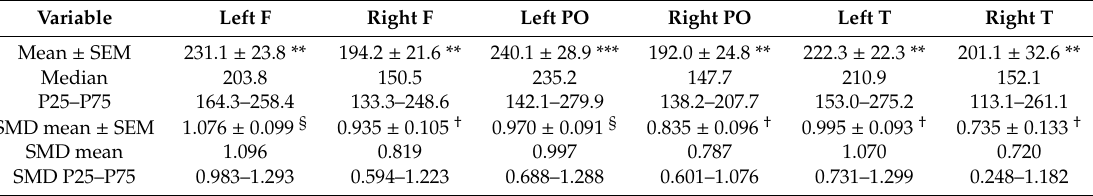
Table A8. Changes in power of alpha bands during FS.